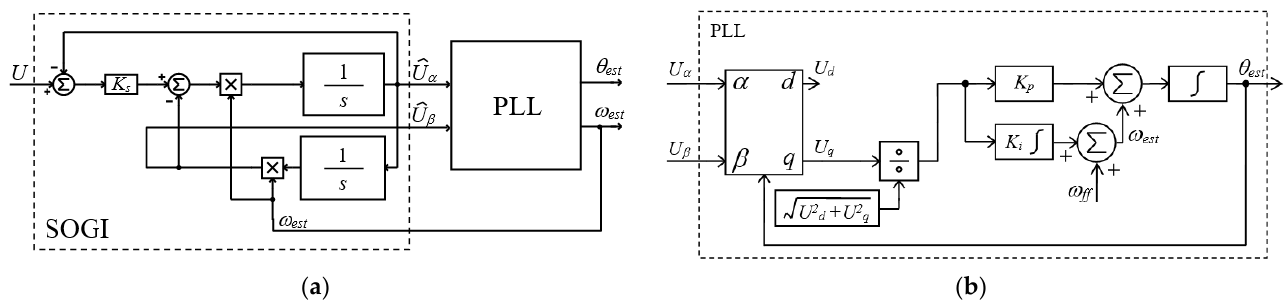
Figure 1. A conventional adaptive frequency SOGI based single-phase PLL, ( a ) general structure with SOGI input section, and ( b ) PLL section.